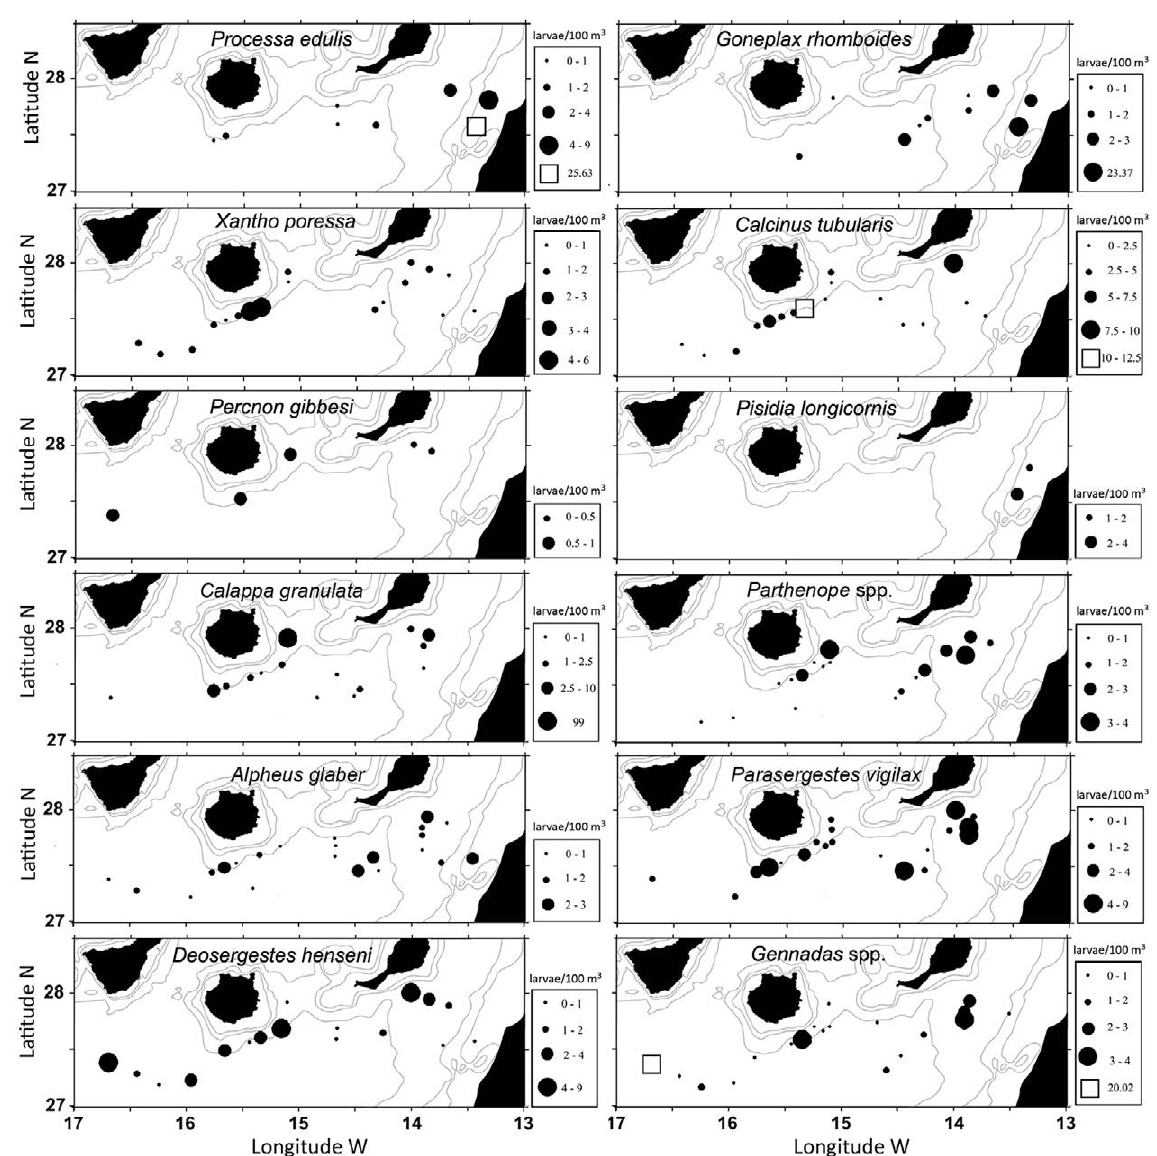
Fig. 5. – Horizontal distribution of decapod larvae abundances. Symbol size and shape represents abundance (larvae/100 m 3 ), as indicated in the